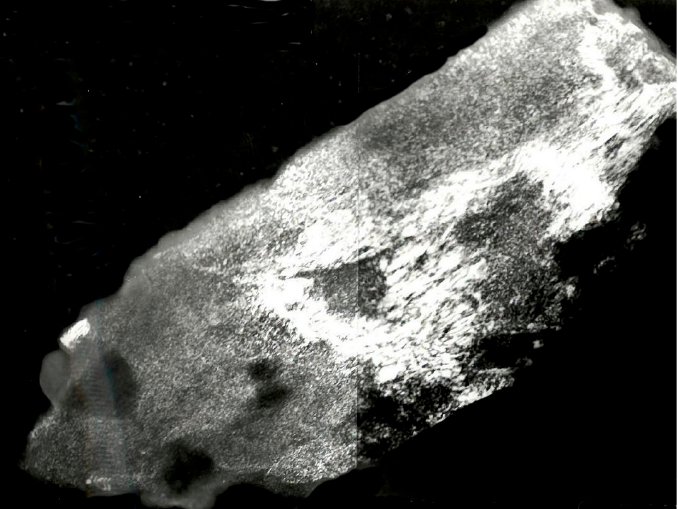
Figure 24. Fragment of anorthite (HEM 18.00).